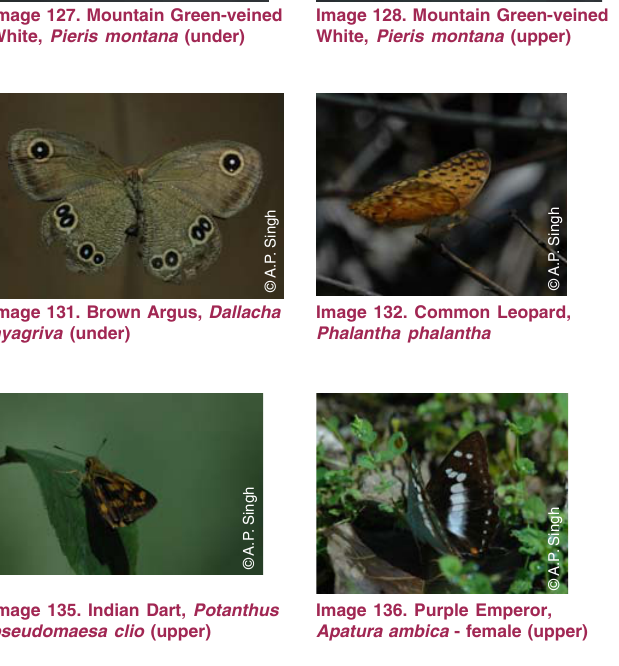
Image 137. Red Himalayan Flash, Rapala selira